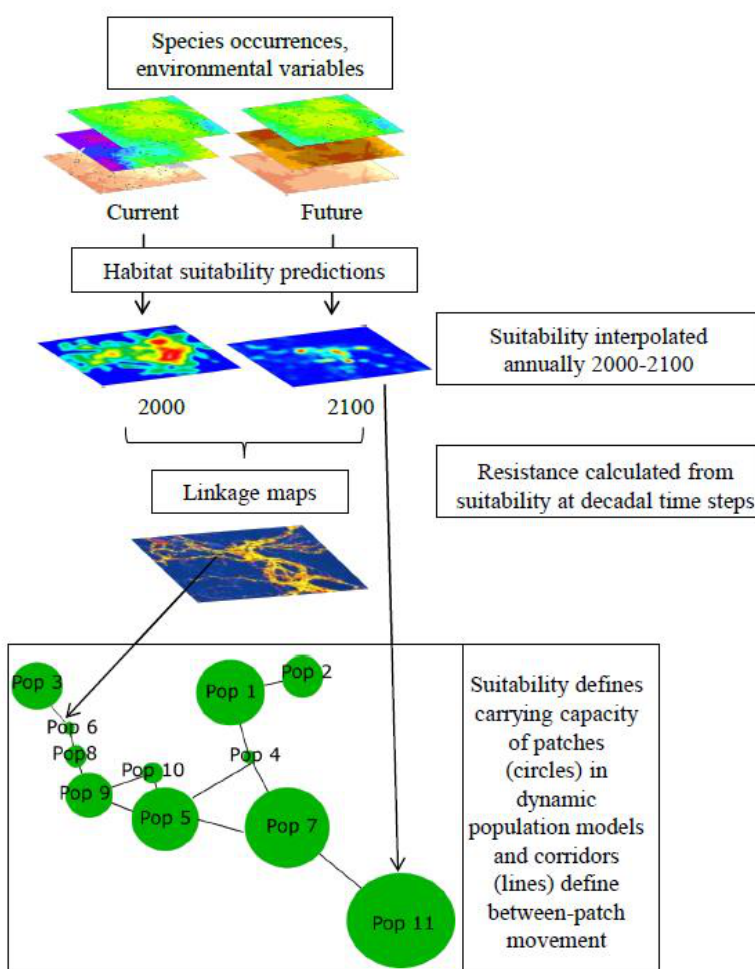
Figure 2. Diagram of the analytical process for patch, linkage, and metapopulation modeling. Analysis starts with occurrence points for focal species and their association with climatic and environmental variables. From those points, suitability maps are generated under historic and future conditions. Suitability is converted to resistance, which is used in linkage modeling. Both the habitat